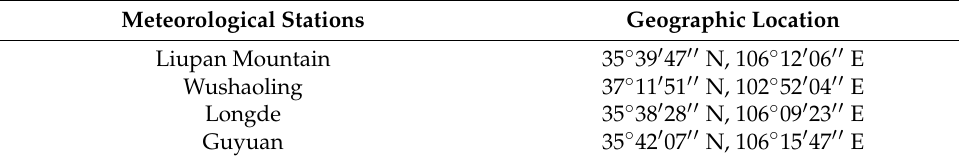
Table 4. Location of historical meteorological